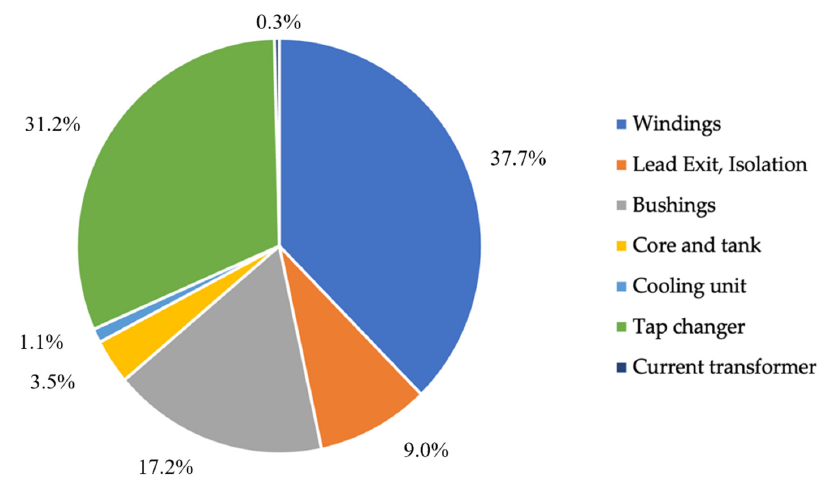
Figure 1. Failure location of substation transformers based on 536 failures [6].